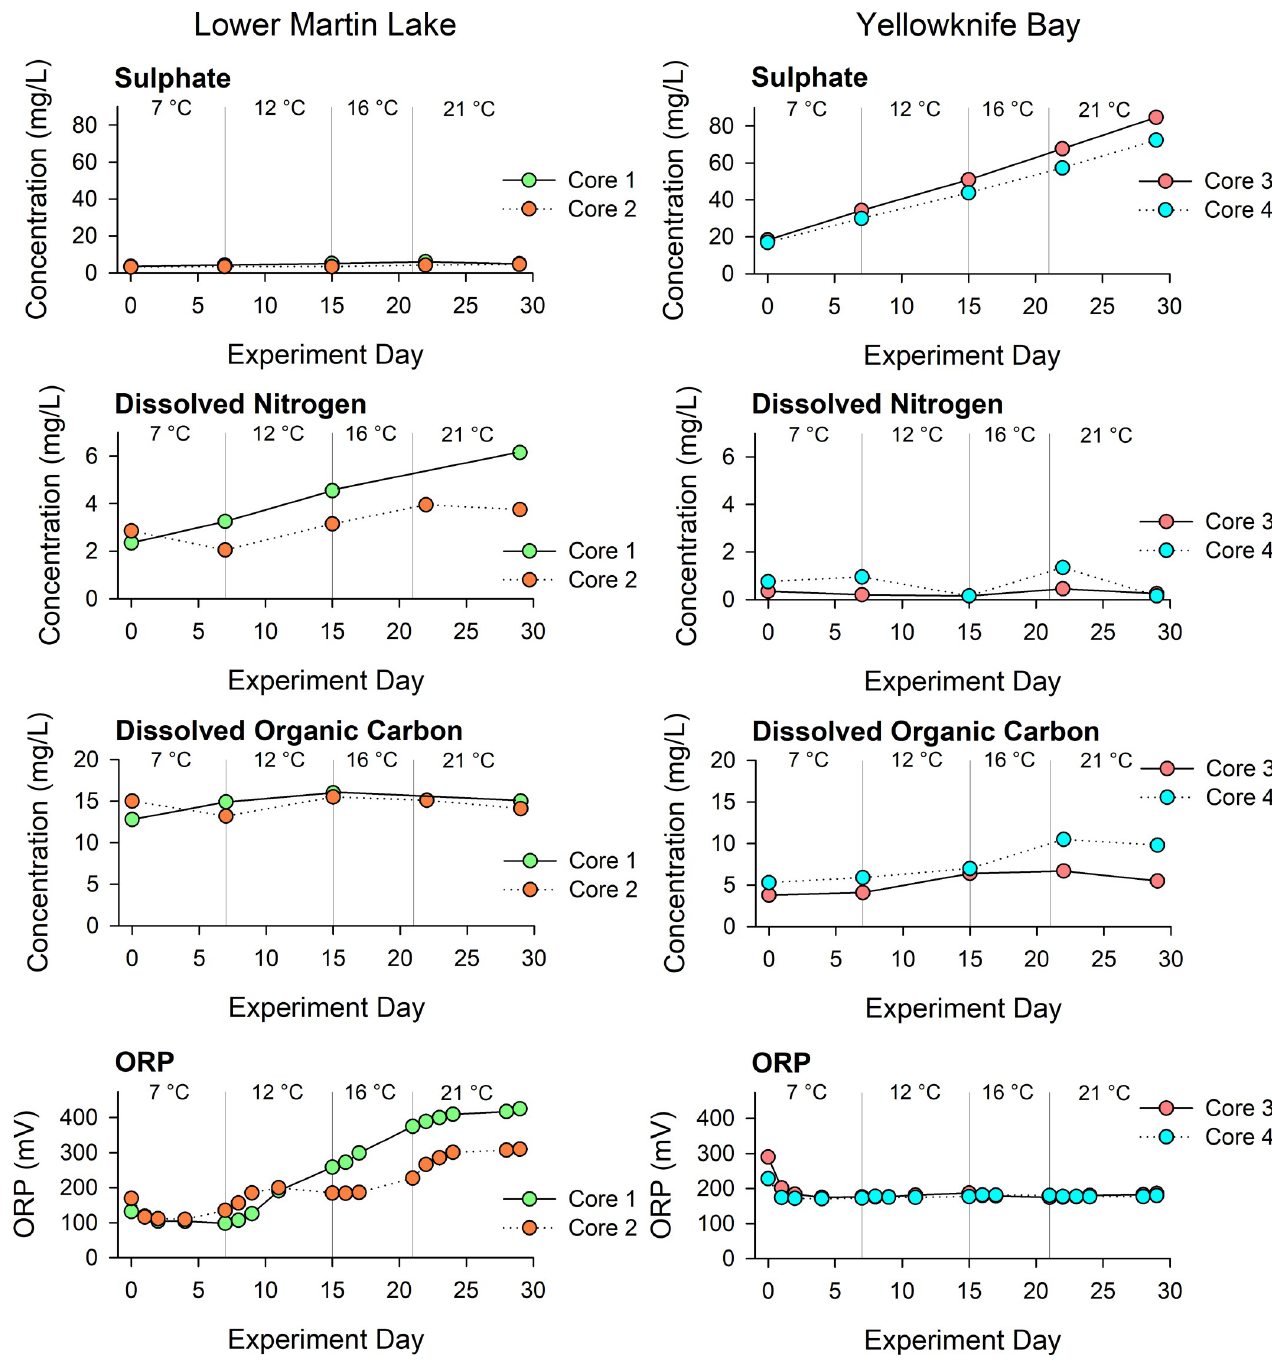
Fig 4. Time series of water quality measurements on overlying water. The concentrations of SO 42- , DN and DOC and ORP of overlying water in the duplicate Lower Martin Lake and Yellowknife Bay cores throughout the 30-day experiment. Each vertical grey line represents a new temperature treatment. The precision of SO 42- , DN, and DOC concentrations is estimated at < 10% based on RSD of three duplicates.